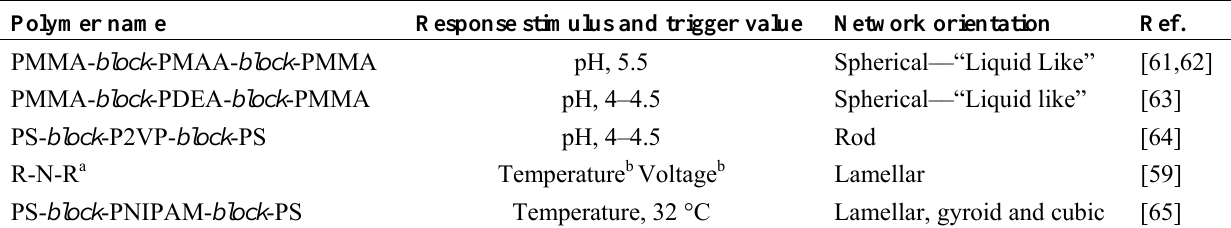
Table 1. Range of polymer actuators with their respective structural architecture, responsive nature and specific stimulus